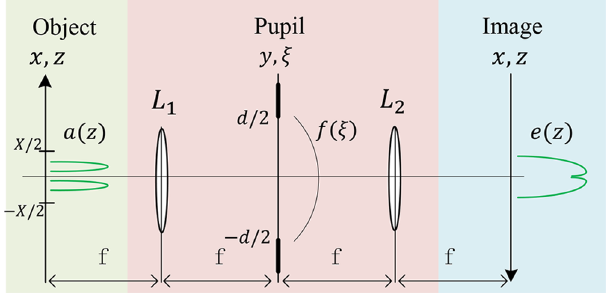
Figure 9. The traditional imaging system, including the object field a ( z ), the first lens ( L 1 ), the field in the pupil plane f (ξ) , the second lens ( L 2 ), and the field in the image plane e ( z ). X denotes the width of the object field and d represents the finite size of pupil. For convenience, the dimensionless spatial coordinates z 2 y / d in the pupil plane are object and image planes and ξ =